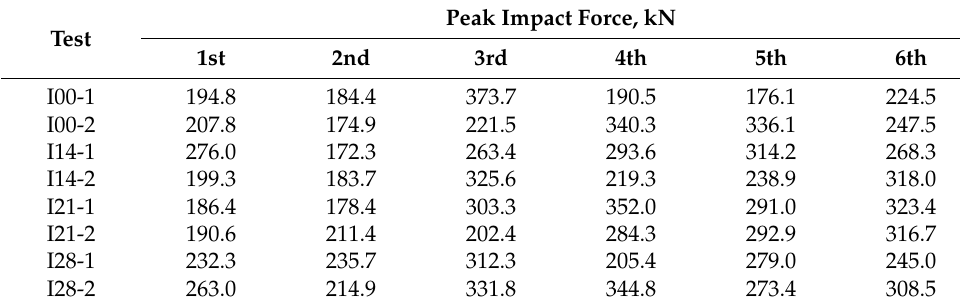
Figure 5. Midspan deflection time history: ( a ) specimen I00-1 and ( b ) specimen I28-2. Table 2. Peak impact force.